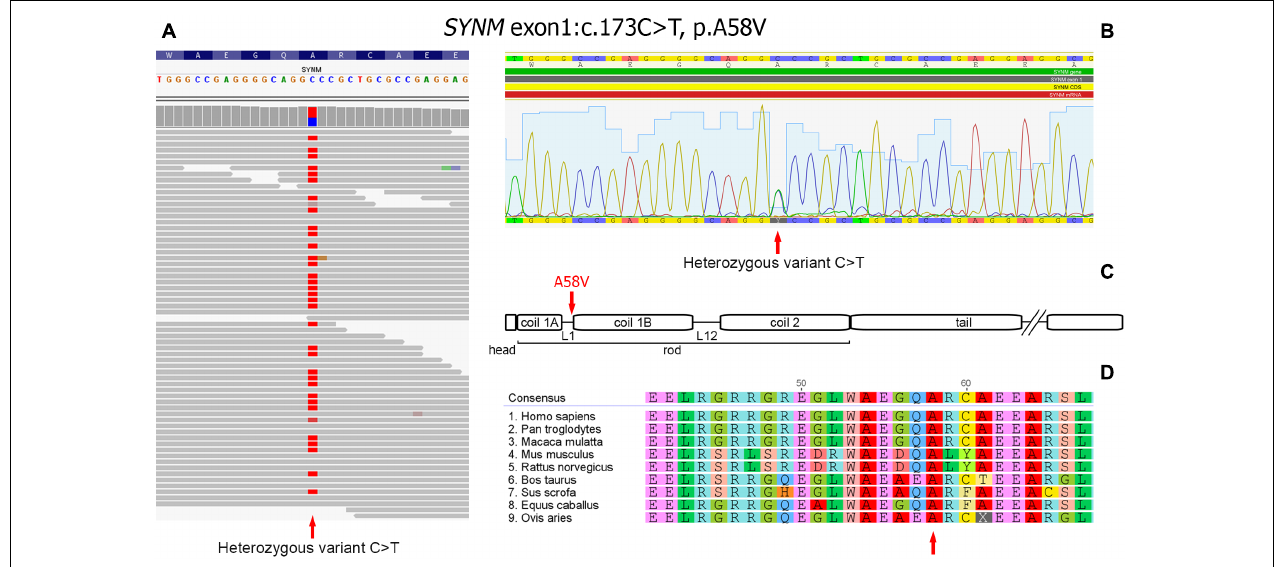
FIGURE 3 | Heterozygous missence variant in SYNM c.173C > T (p.A58V). (A) Identification of the variant by WES. The variant position is pointed by an arrow. (B) Validation of WES results by Sanger sequencing: a fragment of sequencing chromatogram. Heterozygous C/T variant is pointed by an arrow. (C) Position of the amino acid change in synemin protein (shown by an arrow). Protein domain structure is depicted according to UniProt (http://www.uniprot.org). (D) Evolutionary conservation analysis of the amino-acid position across mammalian species (shown by an